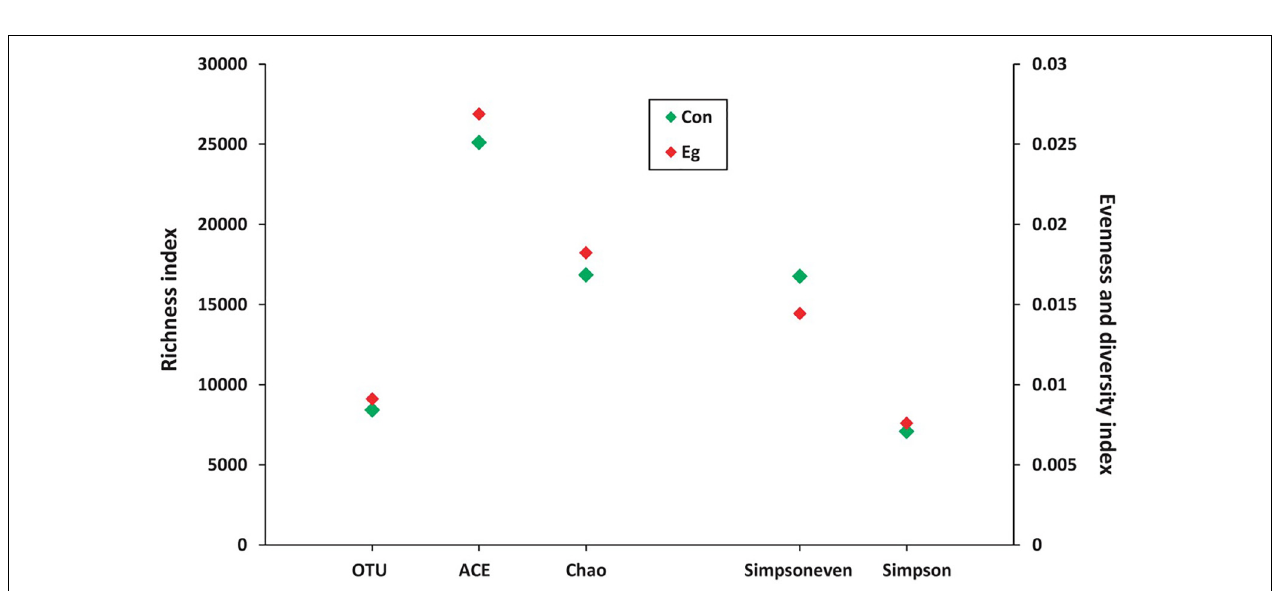
FIGURE 3 | The microbial diversity variability in mice infected (Infected Group) or uninfected (Uninfected Group) with E. granulosus . LEfSe analysis showed the composition of the bacterial populations in the guts of the infected and uninfected mice was similar, whereas richness, evenness and diversity were no changed.